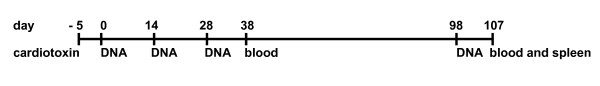
Immunization scheme. Mice were immunized four times with DNA on days 0, 14, 28 and 98. Cardiotoxin pre-treatment was carried out 5 days prior the first DNA immunization. Blood was collected twice, on days 38 and 107. Splenocytes were isolated on day 107 and analyzed by ELISPOT assay.